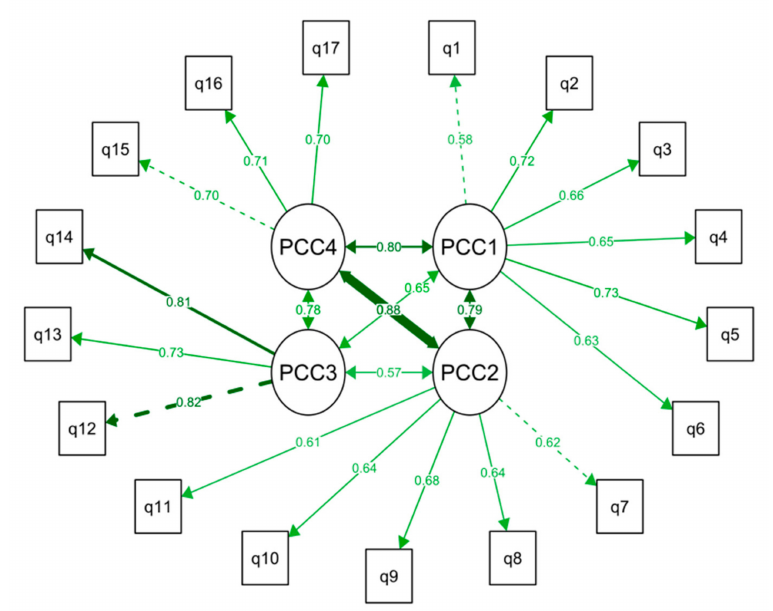
Figure 1. Construct validity of the Patient-centred Care (PCC) instrument based on confirmatory factor analysis (CFA) and inter-scale correlations PCC1–PCC4. q refers to items, numbers refer to factor loadings within each sub-scale. Model fit statistics: comparative fit index (CFI) 0.93, Tucker– Lewis index (TLI) 0.92, goodness-of-fit index (GFI) 0.99, adjusted goodness-of-fit index (AGFI) 0.99, root mean square error of approximation (RMSEA) 0.065, standardized root mean square residual (SRMR)